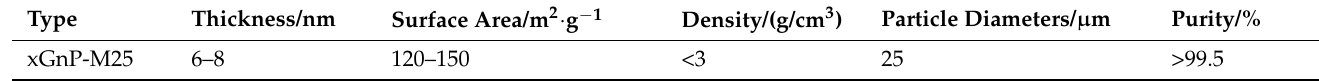
Table 3. Characteristics of